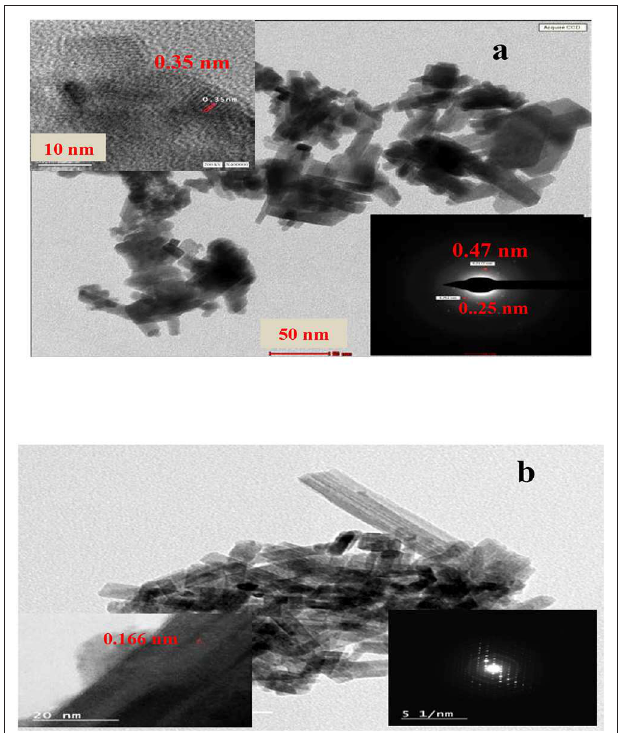
FIGURE 2 | TEM, HREM, and SAED (inset) images of GO inset in (a) WO3 (a) 1%GO.WO3 (b) catalysts.